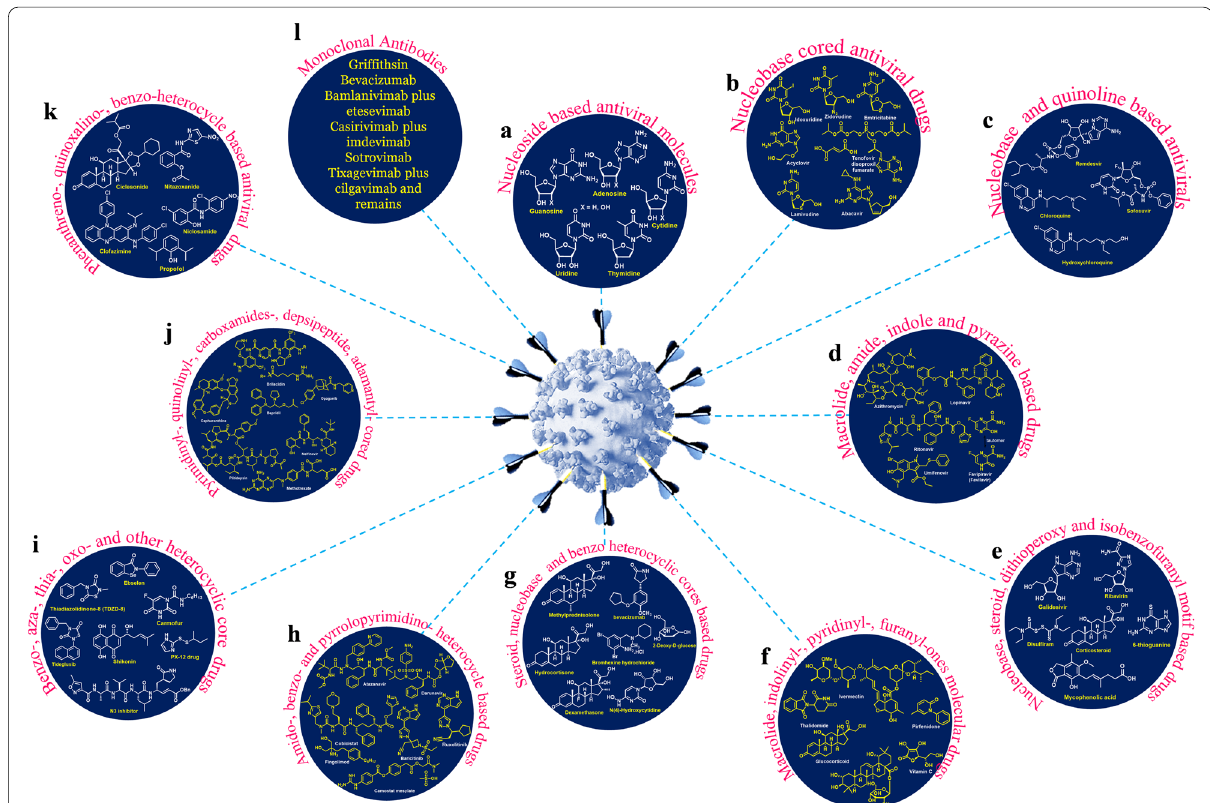
Fig. 9 Illustrative examples of antiviral drugs and monoclonal antibodies assembly along with distinctive frameworks including a Nucleoside based antiviral molecules: adenosine, guanosine, cytidine, thymidine, and uridine entities; b Nucleobase cored antiviral drugs: idoxuridine, zidovudine, emtricitabine, lamivudine, abacavir acyclovir and tenofovirdisoproxil fumarate; c Nucleobase and quinoline based antivirals: remdesvir, sofusbuvir, chloroquine and hydroxychloroquine; d Macrolide, amide, indole and pyrazine based drugs: azithromycin, lopinavir, ritonavir, umifenovir and favipiravir (favilavir); e Nucleobase, steroid, dithioperoxy and isobenzofuranyl motif based drugs: ribavirin, galidesvir, corticosteroid, disulfiram, 6-thioguanine and mycophenolic acid; f Macrolide, indolinyl-, pyridinyl-, furanyl-ones molecular drugs: arjunetin, ivermectin, thalidomide, glucocorticoid, pirfenidone and vitamin C (ascorbic acid); g Steroid, nucleobase and benzo heterocyclic cores based drugs: methylprednisolone, bevacizumab, bromhexine hydrochloride, 2-deoxy-2-D-glucose, dexamethasone, and β-d-N4-hydroxycytidine; h Amido-, benzo- and pyrrolopyrimidino- heterocycle based drugs: atazanavir, darunavir, cobicistat, ruxolitinib, baricitinib, fingolimod and comostat mesylate; i Benzo-, aza-, thia-, oxo- and other heterocyclic core drugs: Ebselen, Disulfiram, Tideglusib, Shikonin, Carmofur, PX-12, thiadiazolidinone-8 (TDZD-8) and N3-inhibitor; j Pyrimidinyl-, quinolinyl-, carboxamides-, depsipeptide, adamantyl- cored drugs: brilacidin, opaganib, nelfinavir, bepidril, plitidepsin, methotrexate and cepharanthine; k Phenanthreno-, quinoxalino-, benzo-heterocycle based antiviral drugs: propofol, clofazimine, niclosamide, nitazoxanide, ciclesonide and l Monoclonal antibodies: griffithsin, bevacizumab, bamlanivimab plus etesevimab, casirivimab plus imdevimab, sotrovimab, tixagevimab plus